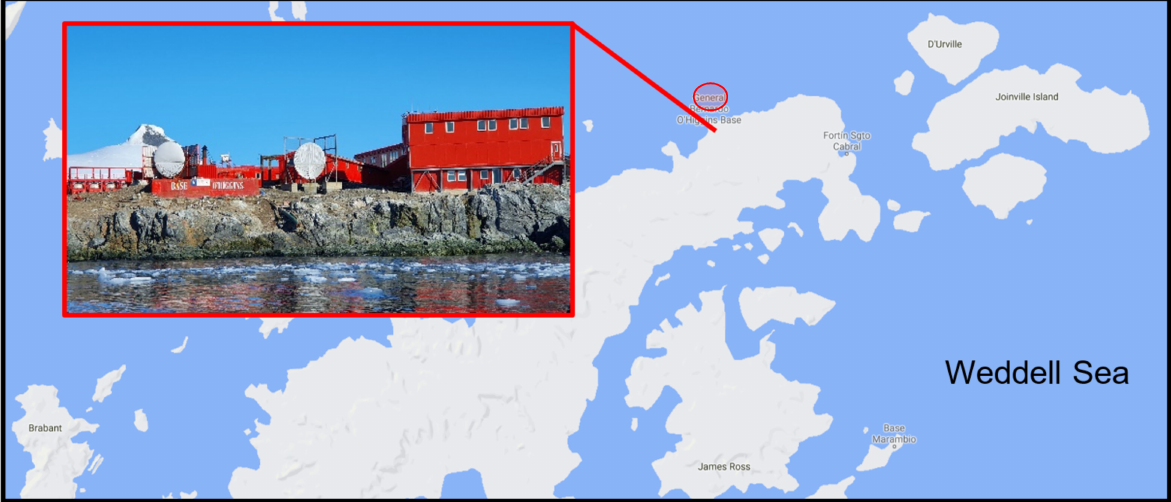
Figure 1. The Chilean year-round operating General Bernardo O’Higgins Riquelme Station located on the Trinity Peninsula, north-west Antarctic Peninsula (63 ◦ 19 (cid:48) S 57 ◦ 54 (cid:48)